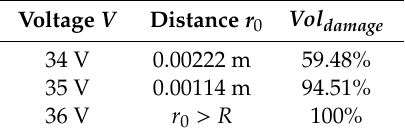
Table 2. The irreversible thermal damage of myxoid liposarcoma tumor at t = 120s.